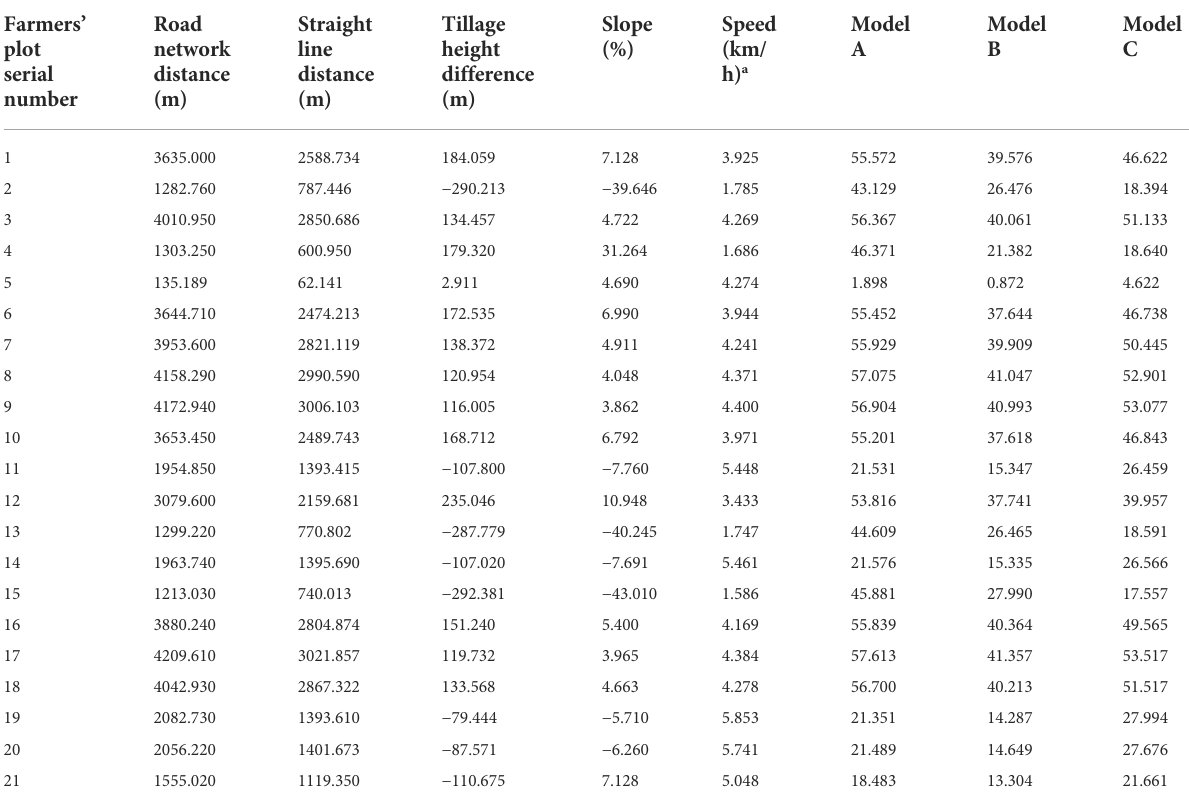
TABLE 3 Farmer sample